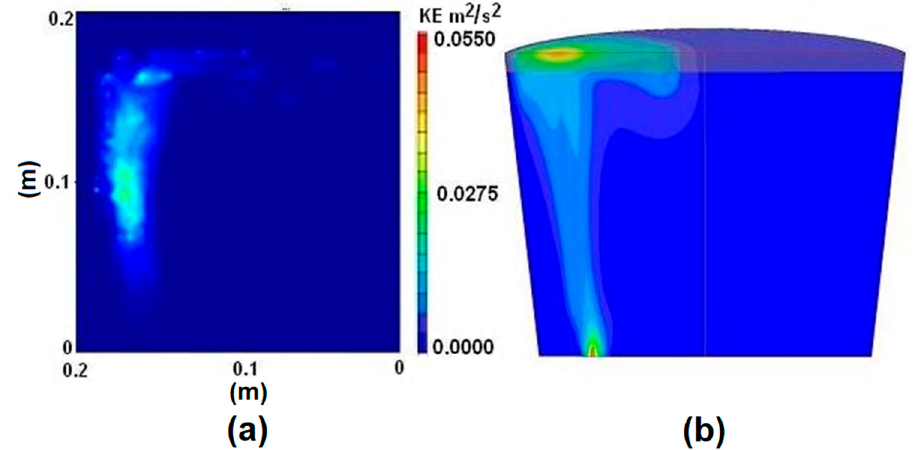
Figure 3. Model validation using turbulent kinetic energy data obtained by ( a ) particle image velocimetry (PIV) and ( b ) numerical simulation. The computational fluid dynamics (CFD) model results show a good prediction of experimental results.